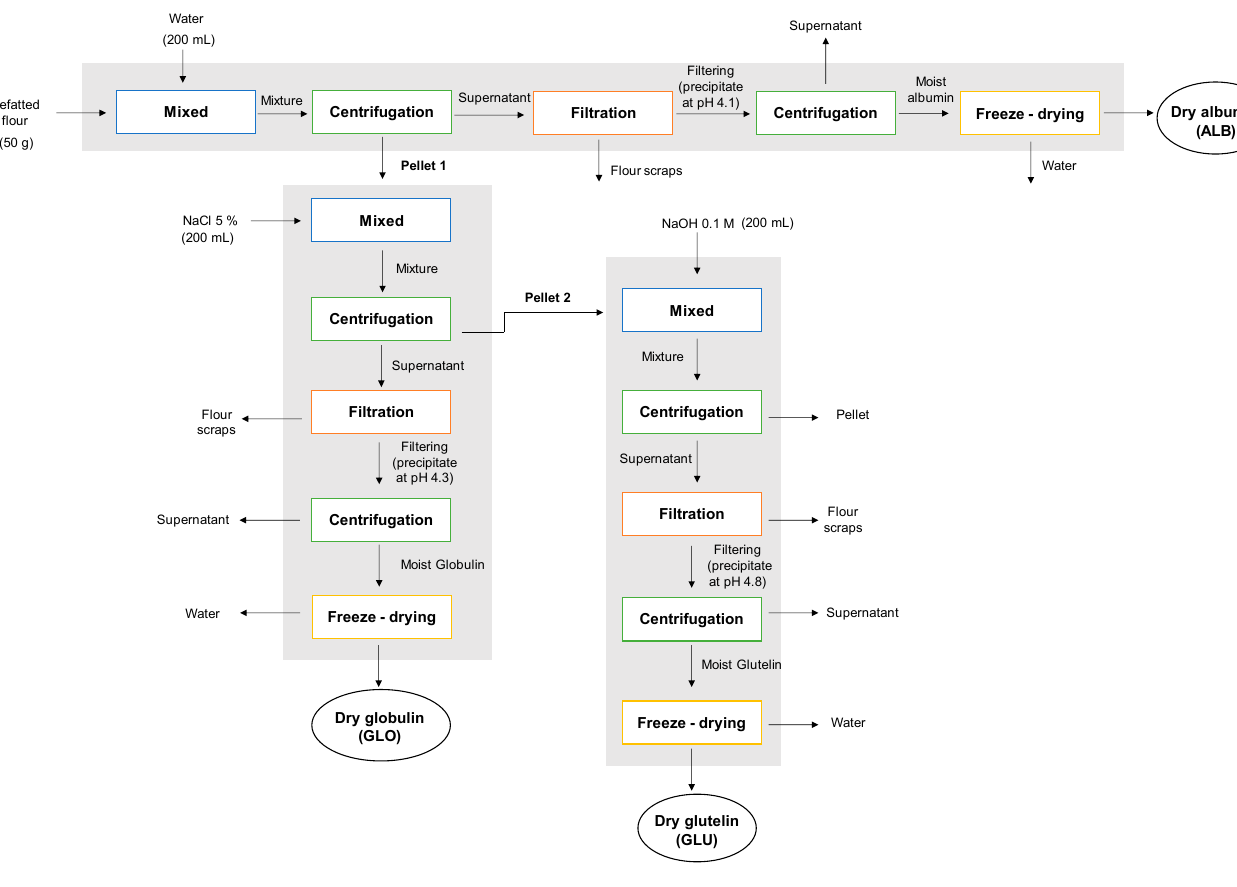
Figure 2. Flow chart describing the sequential extraction method of chickpea protein.